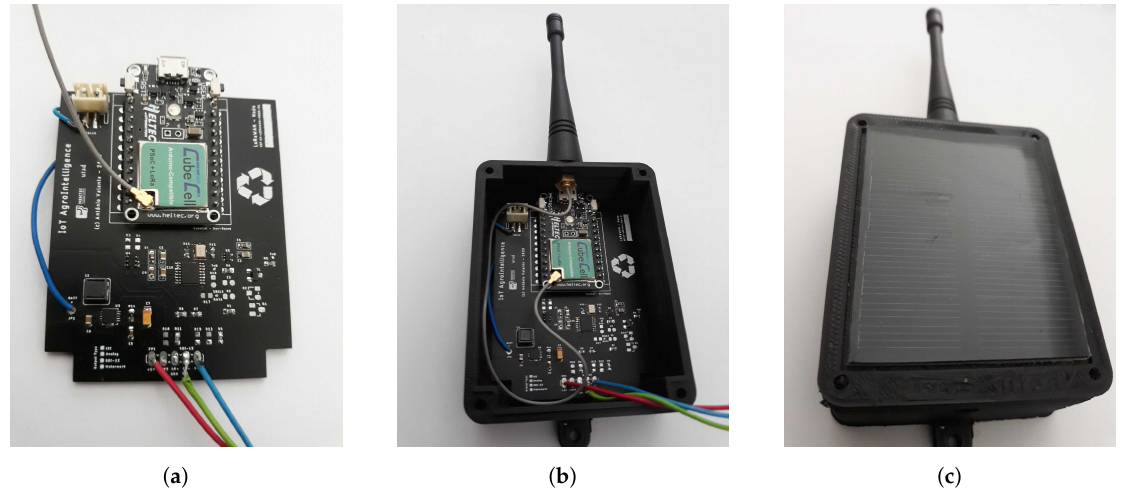
Figure 4. The process sequences to develop HTW module. ( a ) The developed PCB with components; ( b ) 3D printed case with PCB assembled; ( c ) HTW module solar